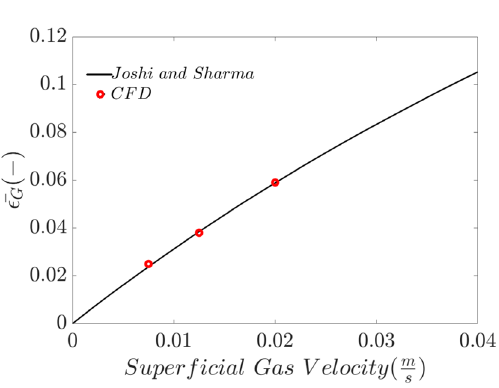
Figure 5. validation of current numerical method (single size Eulerian method) with existing mathematical correlations ( superficialgasvelocity 0.3 + 2 ( superficialgasvelocity ) ), Joshi & Sharma 61